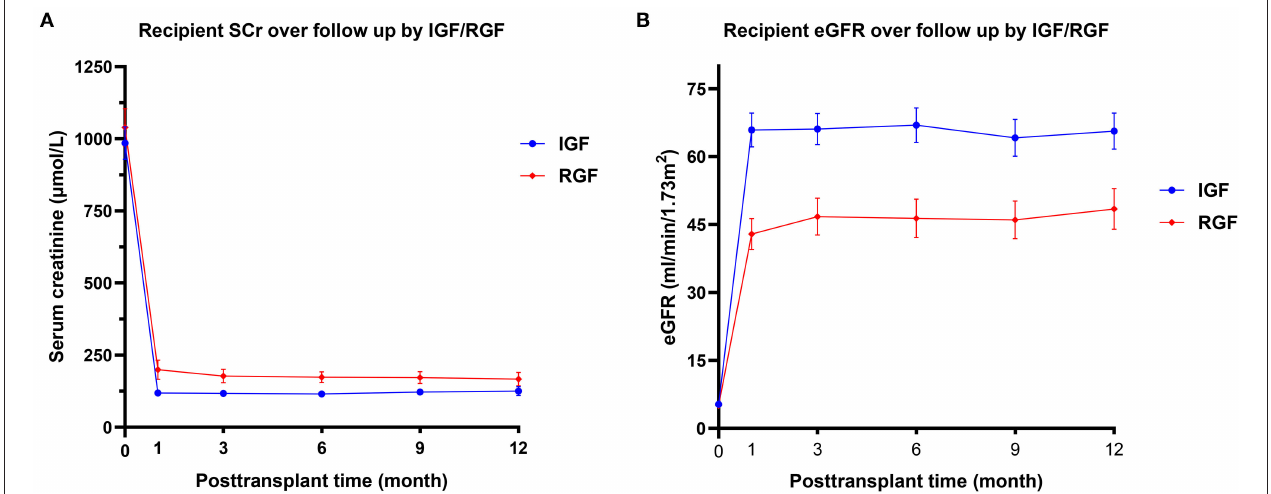
FIGURE 4 | Recipient serum creatinine (A) and eGFR (B) over the first year follow up by immediate graft function (IGF)/RGF. The values of p between IGF and RGF groups at each time point were adjusted by the Holm-Sidak method. Differences in pretransplant serum creatinine and eGFR are not significant, but are significantly different at each time point (adjusted p < 0.01).